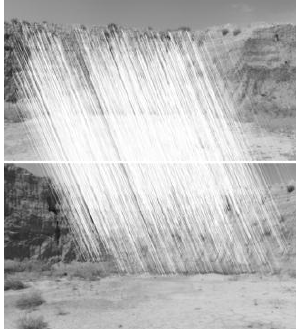
Figure 1. Efficiency of the SIFT in image matching where [ ] and ( ) is the pose of the camera in the (chosen) world reference frame. In the equation above, the matrix K , which is define as